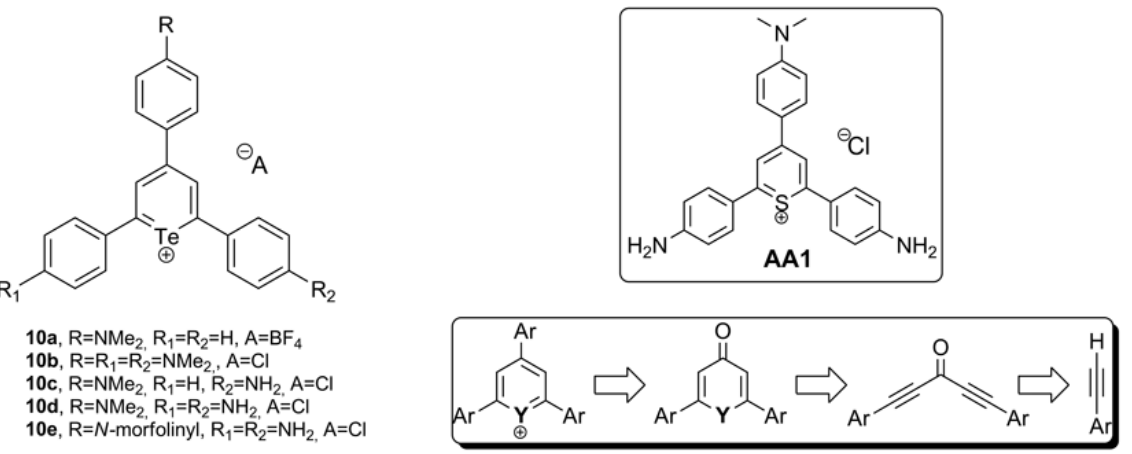
Fig. 8 – Tellura-pyrilium salts related to AA1 and the synthetic approach to their